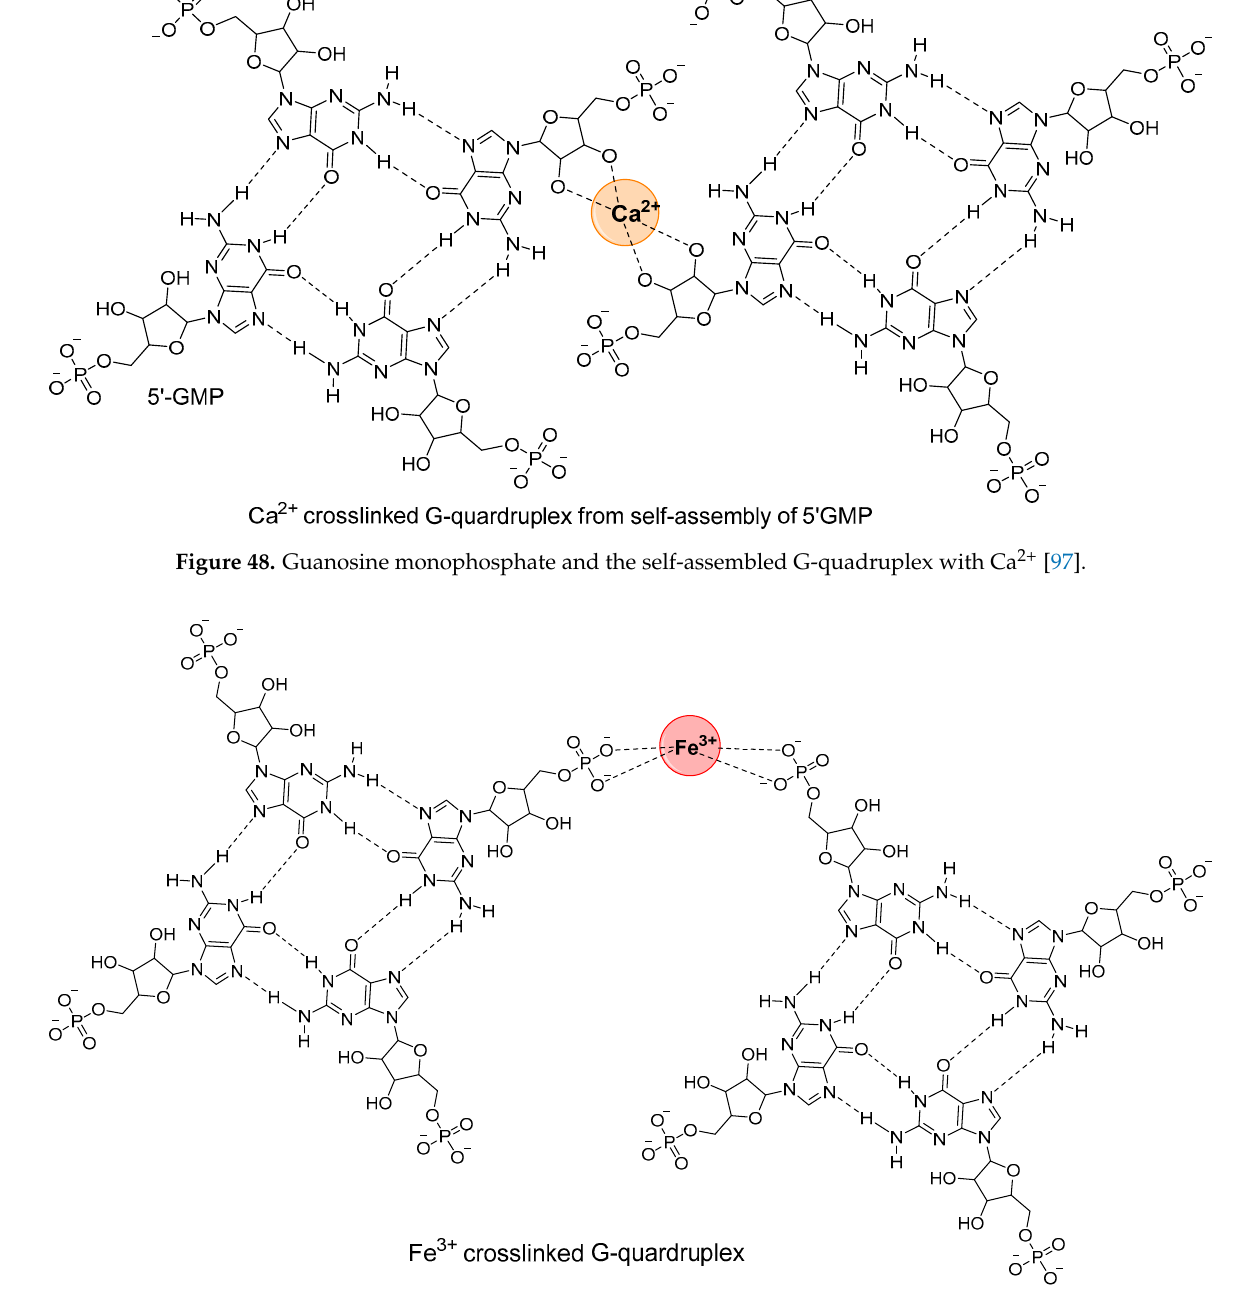
Figure 50. Adenosine nucleolipid derivatives 83a-d and uridine nucleolipid derivatives 84a – e [98]. In a related study, cytidine and ribothymidine acyl derivatives were used for the de- sign of supramolecular gels and stimuli-responsive smart materials (Figure 51) [99]. As previously described, the small variations in the chemical structure can result in a wide